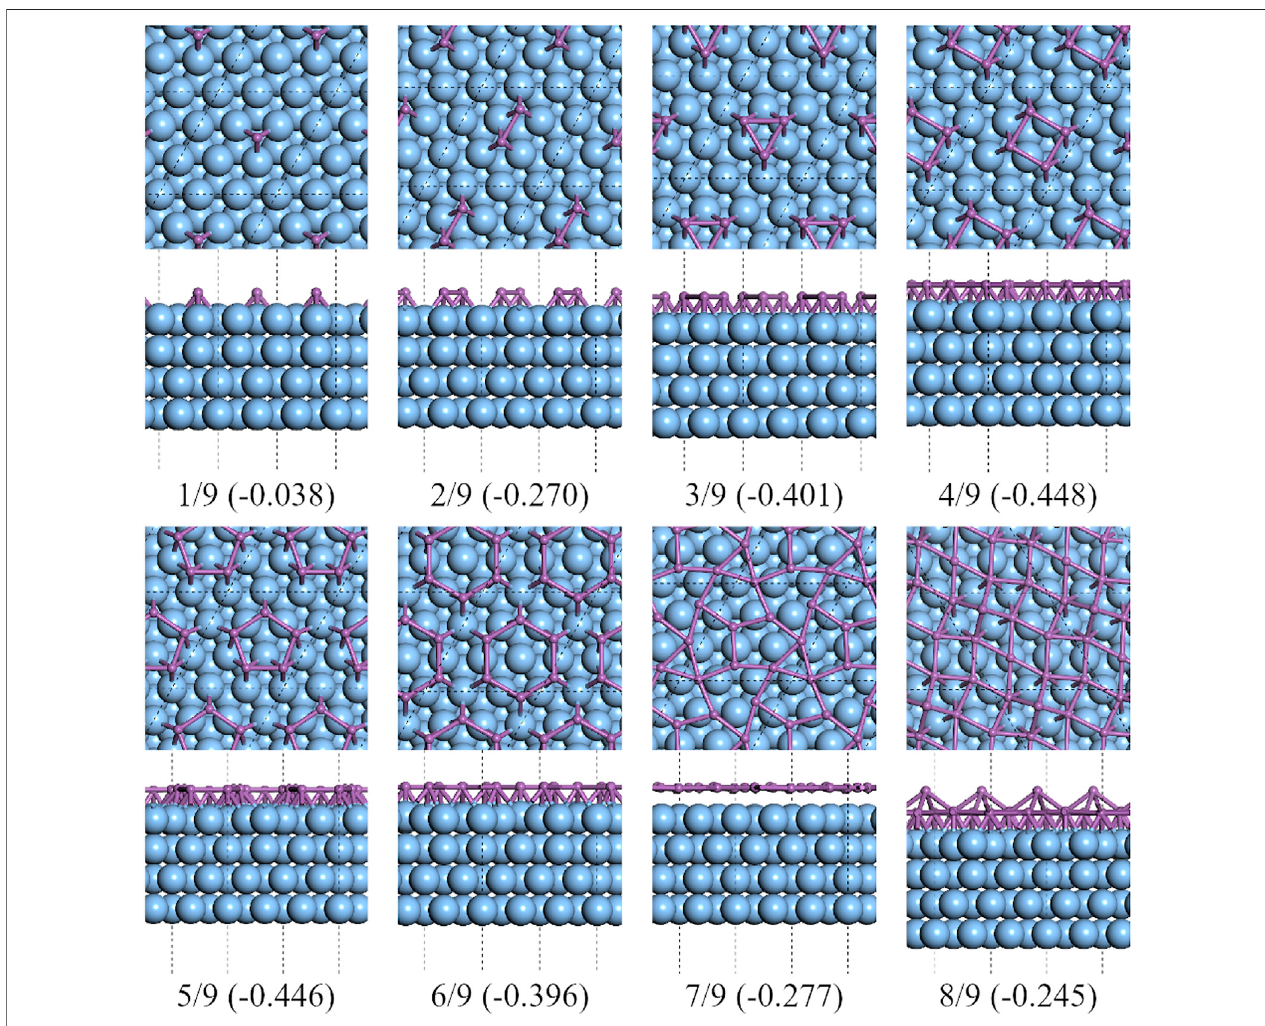
FIGURE 5 | Top and side views of the lowest formation energy favorable con fi gurations of the antimony adsorbed on 3×3 Ag (111) substrate.